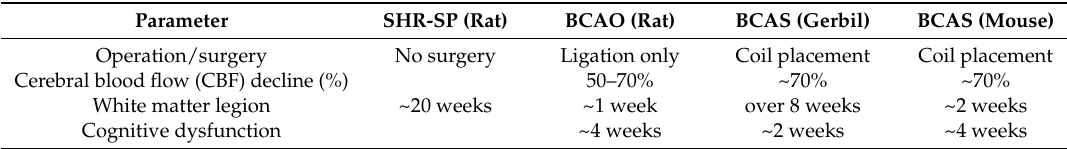
Table 1. Rodent models for vascular cognitive impairment syndrome